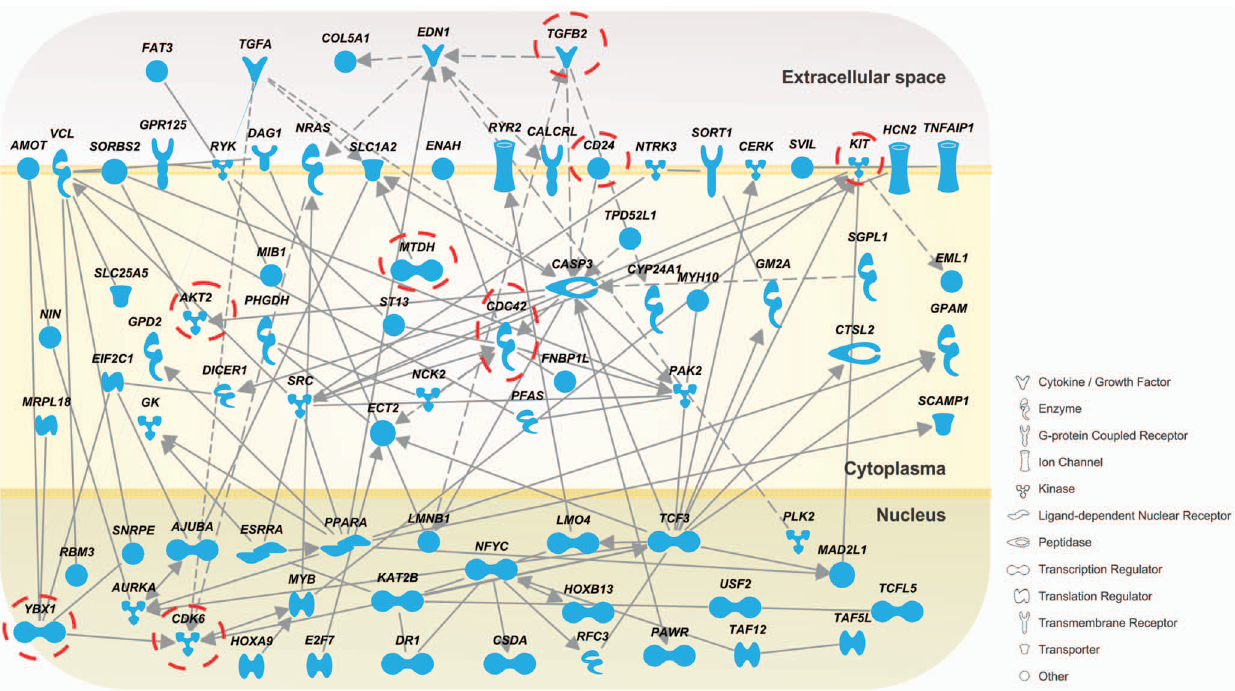
Figure 4. Network analysis. Genes negatively affected by miR-137 mimics transfection as determined by RIPSeq or RNASeq analyses which contain a miR-137 predicted site were connected using Ingenuity Pathway Analysis tool. Solid lines indicate direct interactions; dashed lines indicate indirect interactions. Genes from Table 1 are highlighted (open circle).